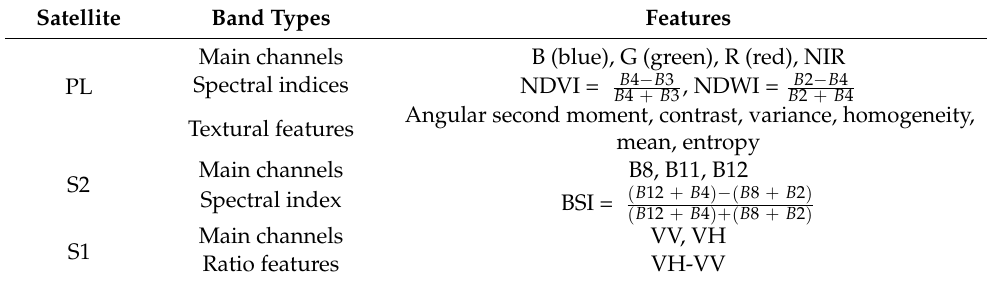
Table 2. The optical, SAR, spectral and textural features applied to the classifications in this study.